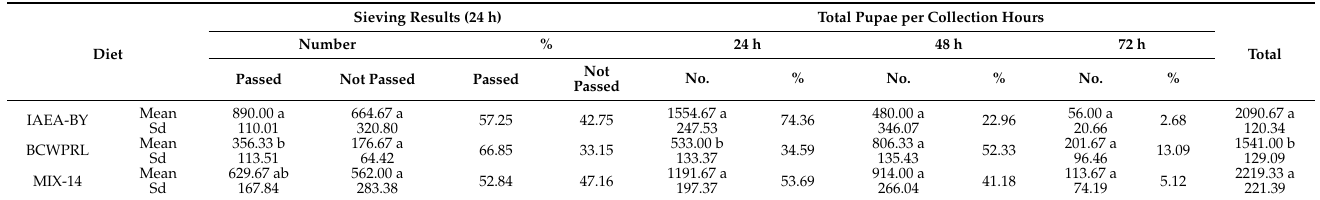
Table 3. The number of male pupae collected 24 h, 48 h, and 72 h after pupation onset and percentages in relation to the total male pupae obtained from variants with different larval